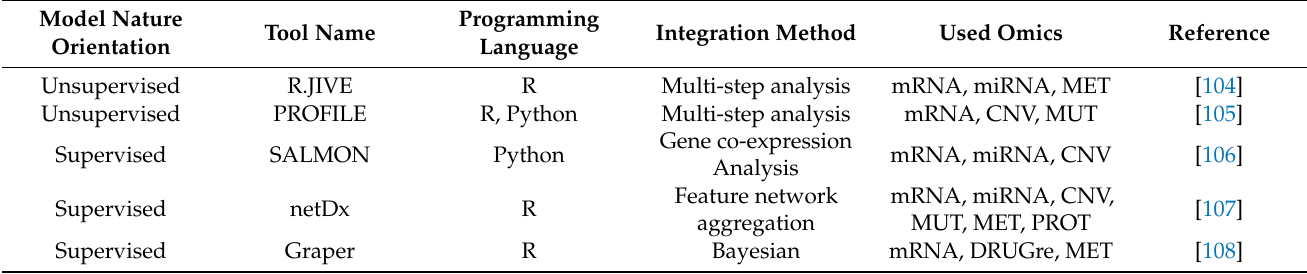
Table 2. Summary of computational tools for patient stratification in the field of multi-omics data integration. Model Nature